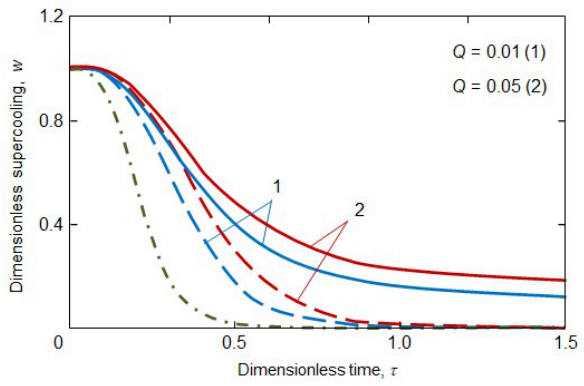
Figure 1. Metastability degree w = ∆ T / ∆ T 0 versus dimensionless time τ = t / t ∗ . The system parameters used in calculations correspond to supercooled melts [51]: B 1 = 49.9, α k = 5.5 · 10 − 4 , p = 7.4, H = 0 (dashed curves) and H = 3 (solid curves). The green dash-dotted curve is plotted for Q = 0 and H = 0.